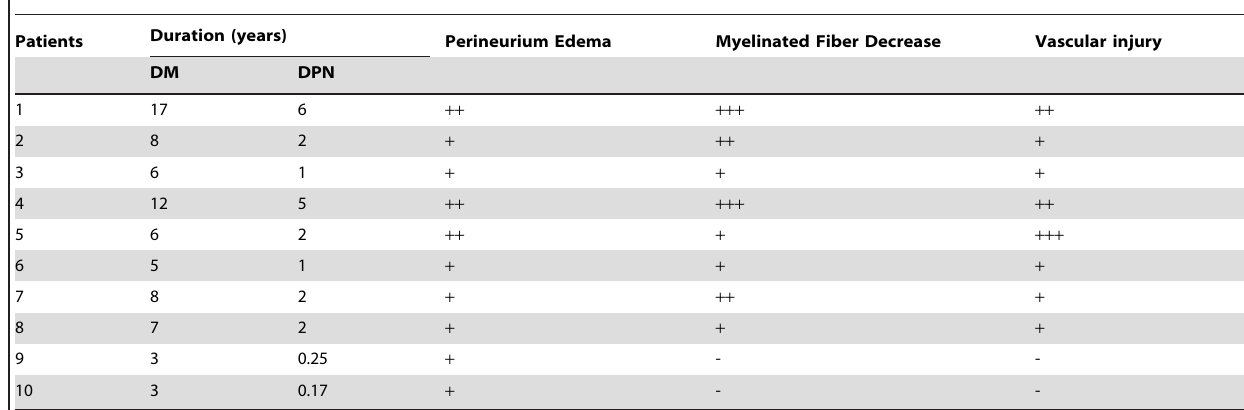
Table 2. Duration and pathologic data of individual patients.